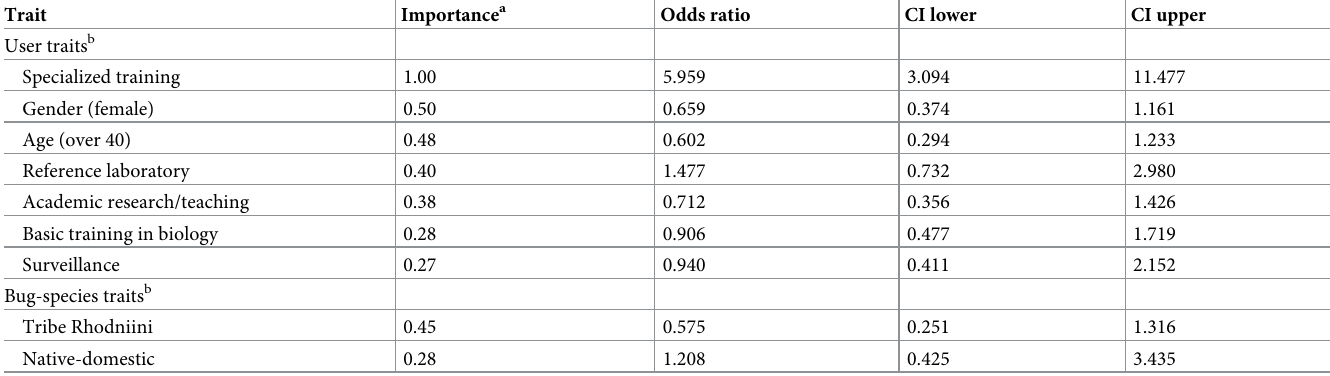
Table 5. T RIATO D EX performance: Importance of variables selected for hypothesis testing and their model-averaged, adjusted effect estimates.